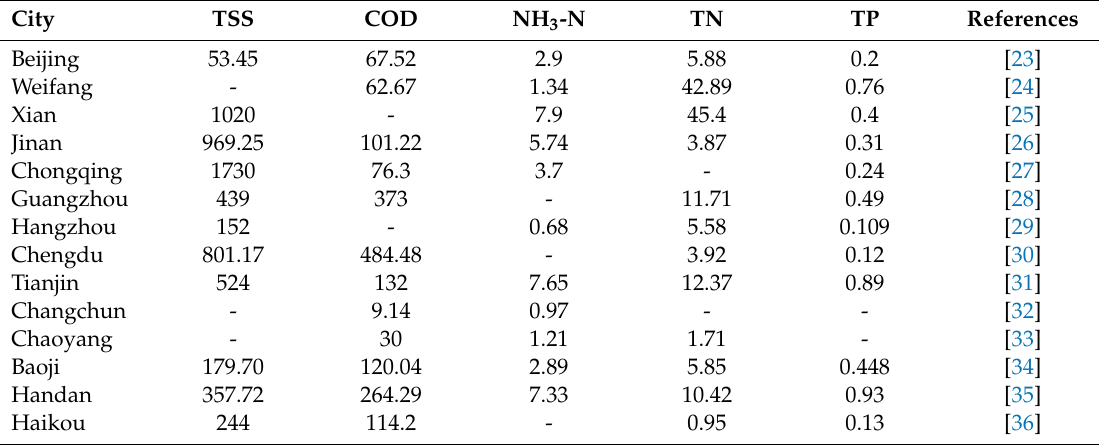
Table 1. Stormwater quality of roads in various cities (mg L − 1 ). COD: chemical oxygen demand; TN: total nitrogen; TP: total phosphorus; TSSs: total suspended solids.